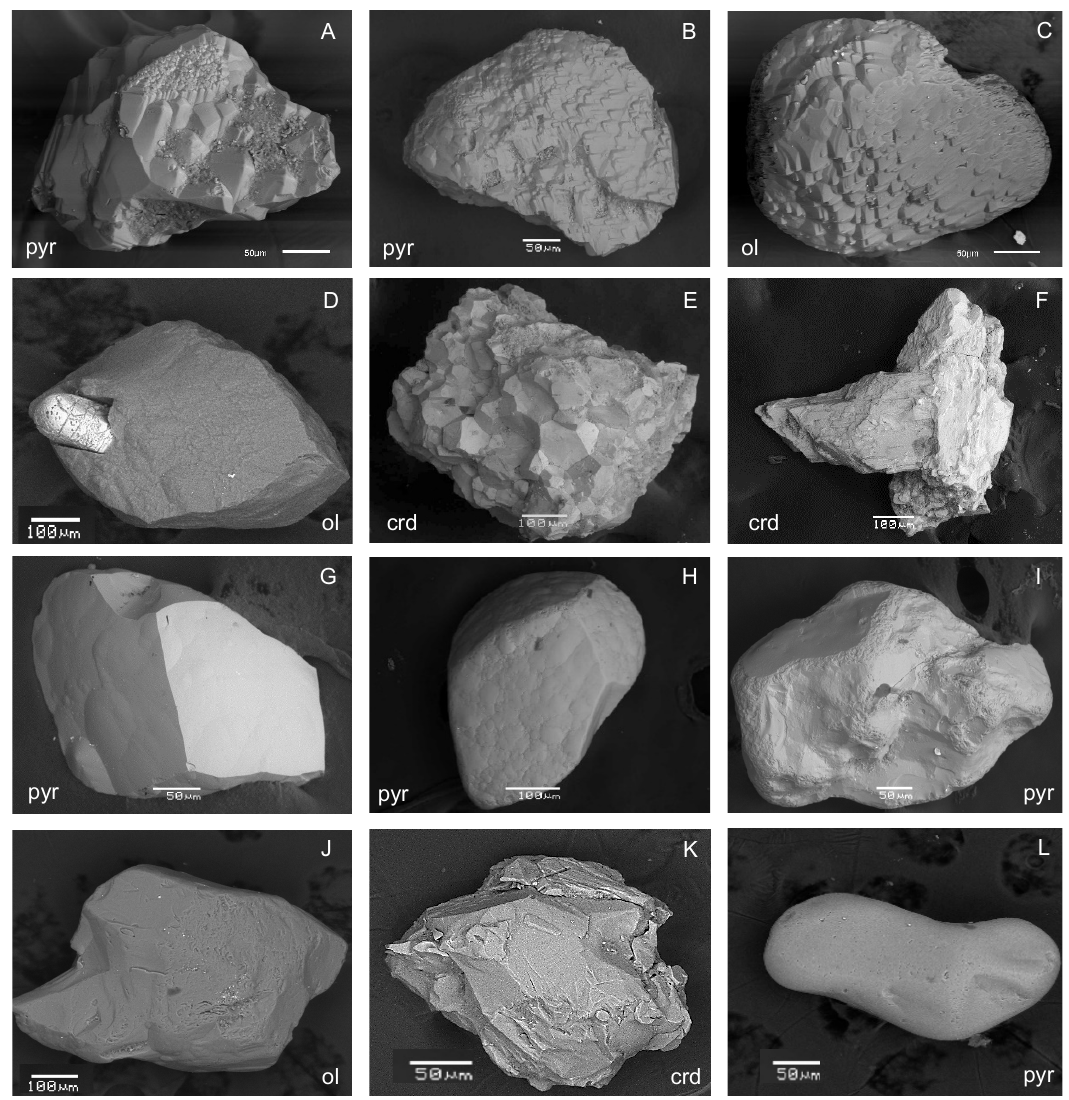
Figure 3. SEM images of Kimberlite Indicator Mineral (KIM) grains. ( A – F ) primary magmatic surface; ( G , H ) chemically abraded surface; ( I – L ) mechanically abraded surface. Pyr, pyrope; ol, olivine; crd, Cr-diopside. Table 1. The percentage (%) of KIM surface morphologies in the samples from the studied areas. P, primary magmatic; C, chemically abraded; M, mechanically abraded; N, number of grains analyzed. Area